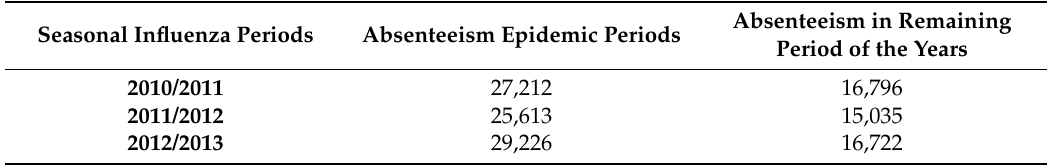
Table 1. Absenteism days in epidemic and remaining period of the